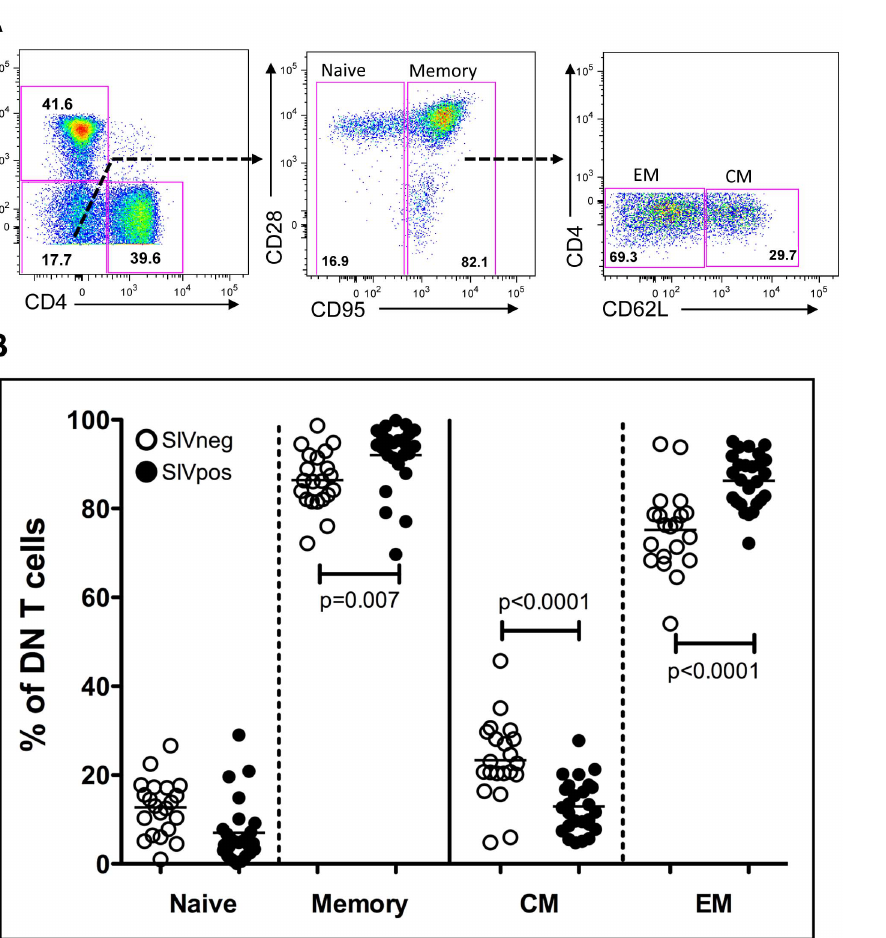
Figure 1. Double negative (CD3 + CD4 2 CD8 2 ) T cells from sooty mangabeys are predominantly effector memory cells. (A) Phenotypic assessment of T cell subsets (CD3 + ) depicting DN T cells (CD4 2 CD8 2 in the lower left quadrant) in sooty mangabey PBMC. Further assessment of naı¨ve (CD95 2 ) and memory DN subsets were performed based on CD95 and CD28 expression. Characterization of central memory (CM: CD95 + CD62L + ) and effector memory (EM: CD95 + CD62L 2 ) DN T cells are depicted. (B) DN T cells from uninfected mangabeys (open symbols) and SIV- infected mangabeys (filled symbols) were evaluated as Naı¨ve, memory, CM and EM subsets and the relative percentage of each is depicted. DN T cells in the PBMCs are primarily memory cells (CD95 + ) with a predominant effector memory